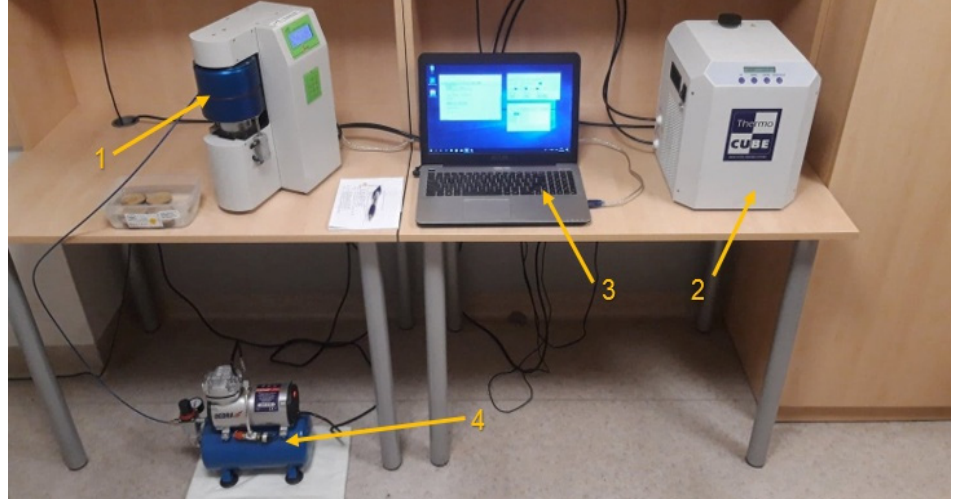
Figure 2. Measuring station, 1—FOX 50 Lambdameter by TA Instruments, 2—ThermoCube 200–500 thermoelectric recirculation cooler by Solid State Cooling System, 3—laptop with Win Therm50v2 software, 4—DED7472 compressor by Dedra.